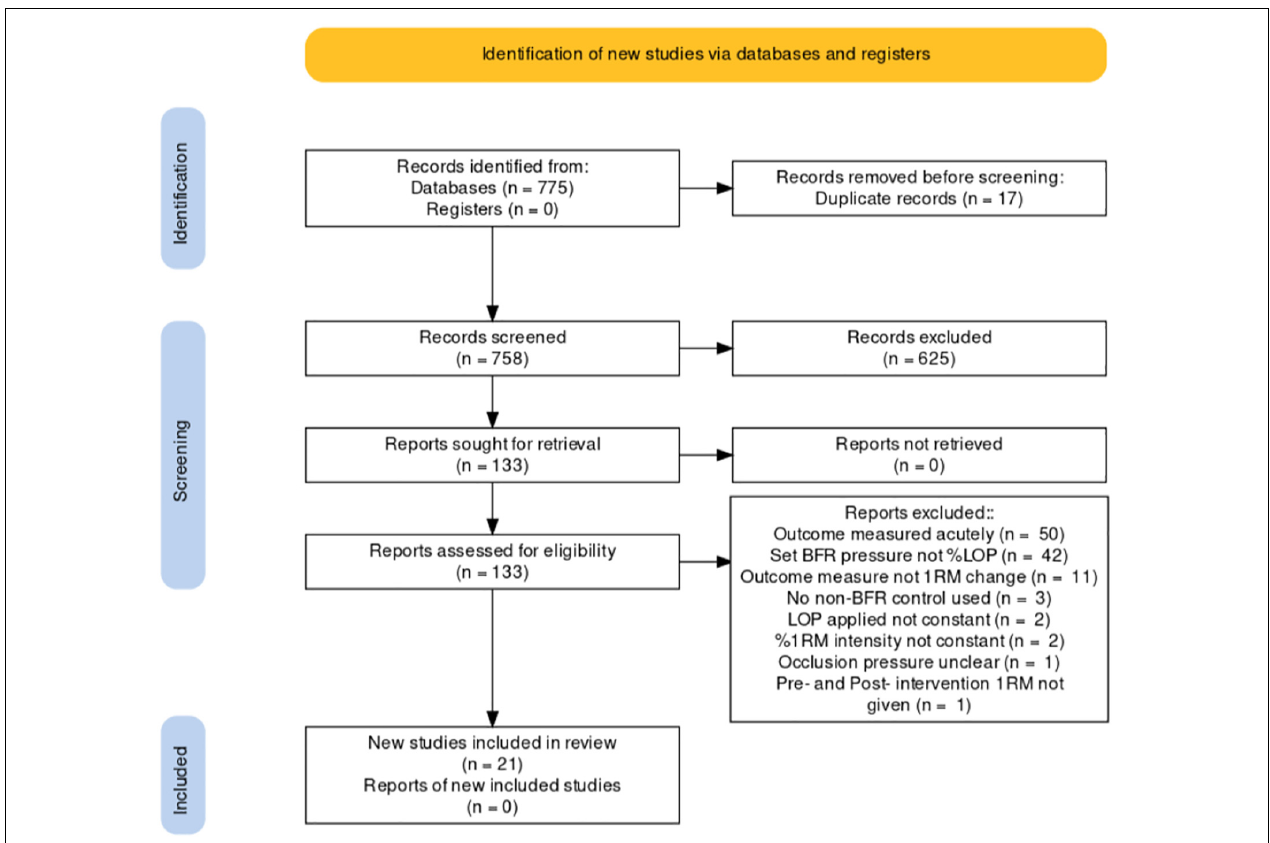
FIGURE 2 | PRISMA flowchart of exclusion process.